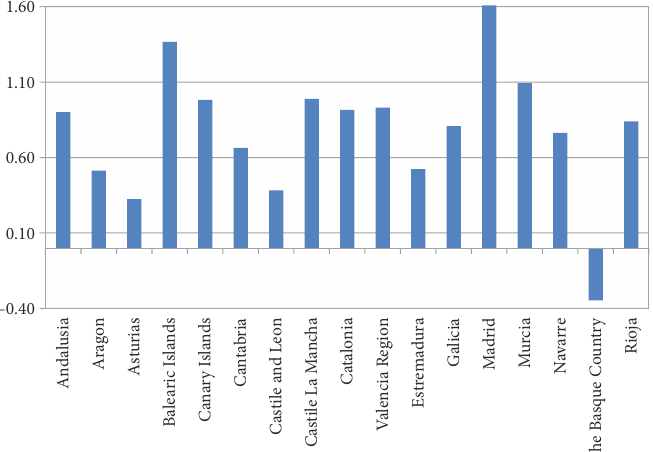
Figure 4. Average variation of businesses for every 1000 inhabitants during the period 2003−2016 (source: compiled by the authors from the